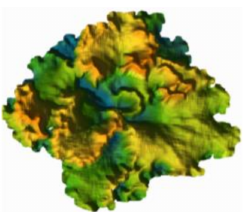
Figure 5. The image of 3D point clouds.